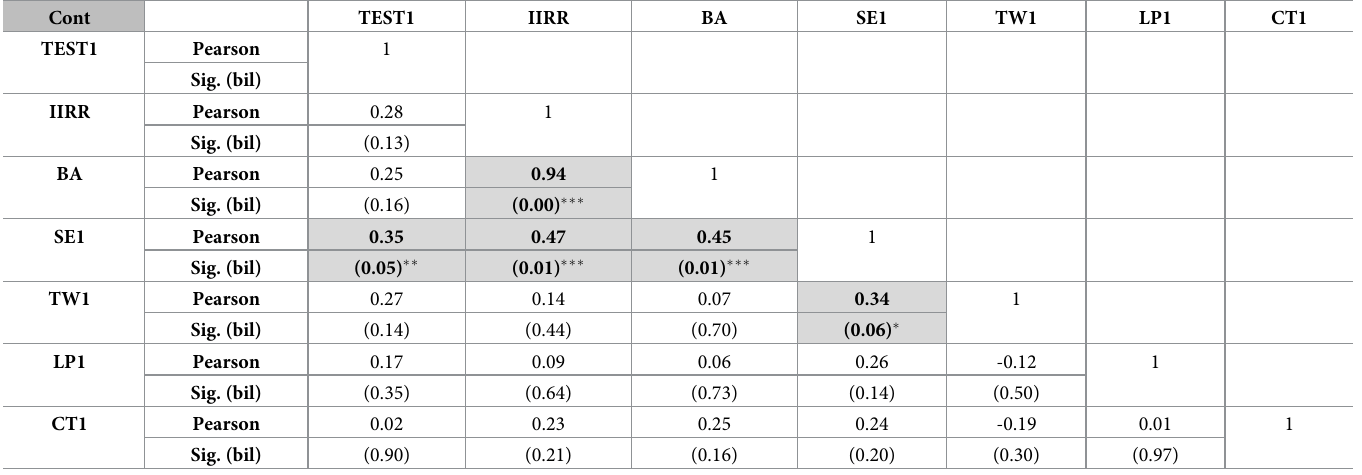
Table 6. Pearson correlations: Control group before the experiment. Cont